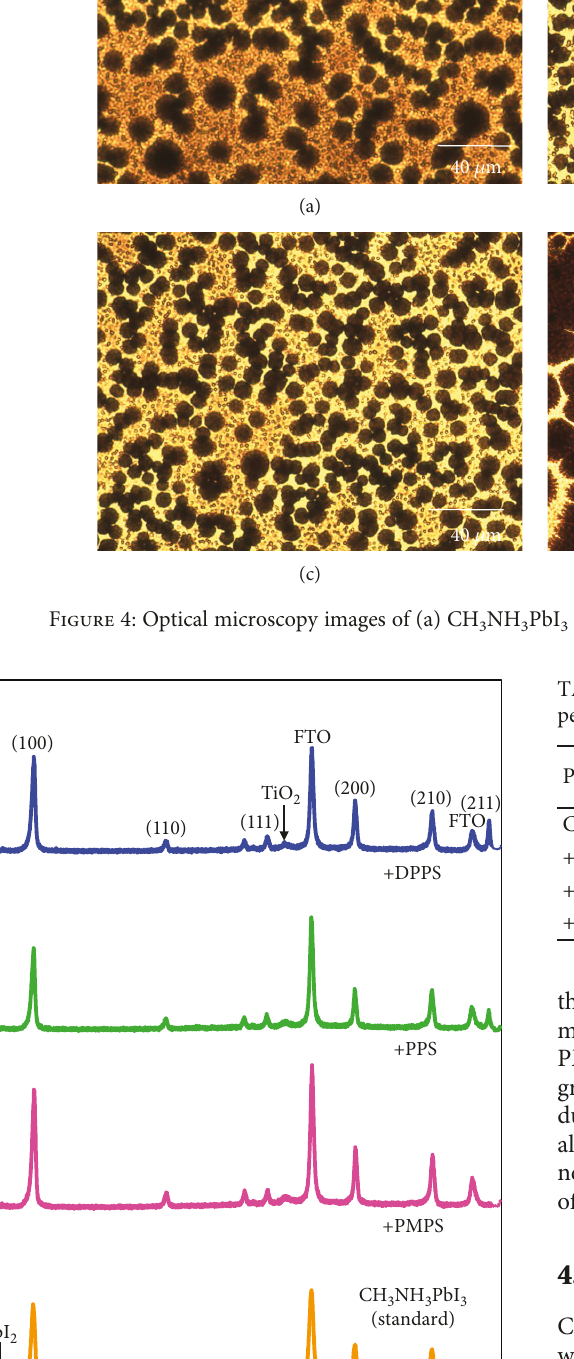
NH PbI solar cells with polysilanes. 3 3 3